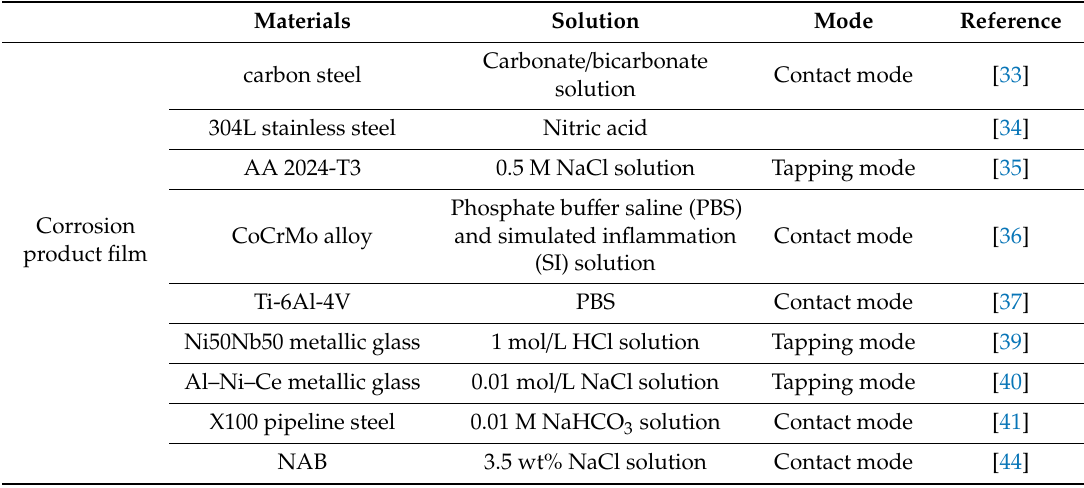
Table 2. Summary of the application of EC-AFM in corrosion product